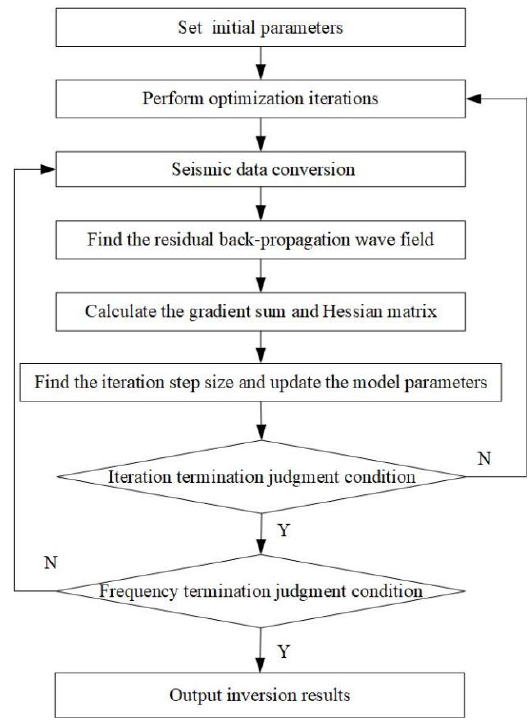
Figure 2. The flow chart of adjusted frequency domain FWI method.